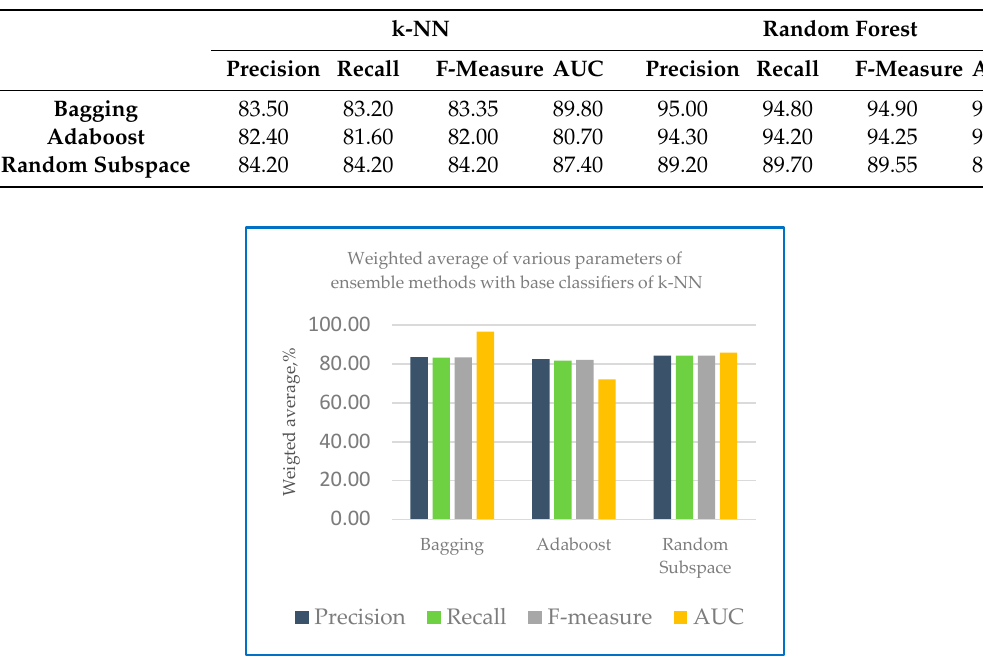
Figure 12. Weighted average of various parameters of ensemble methods with base classifiers of k-NN.